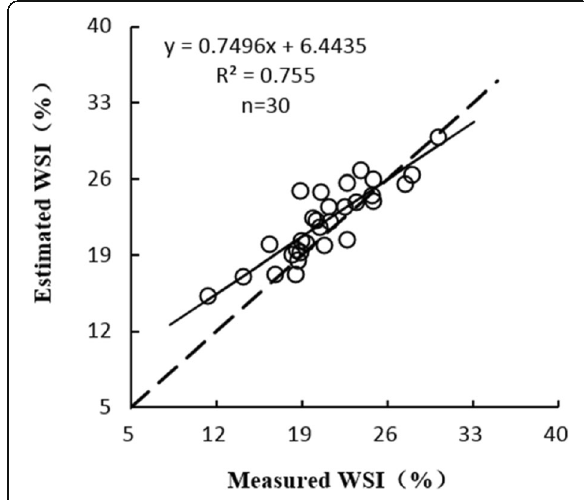
Fig. 5 Comparison of measured and estimated